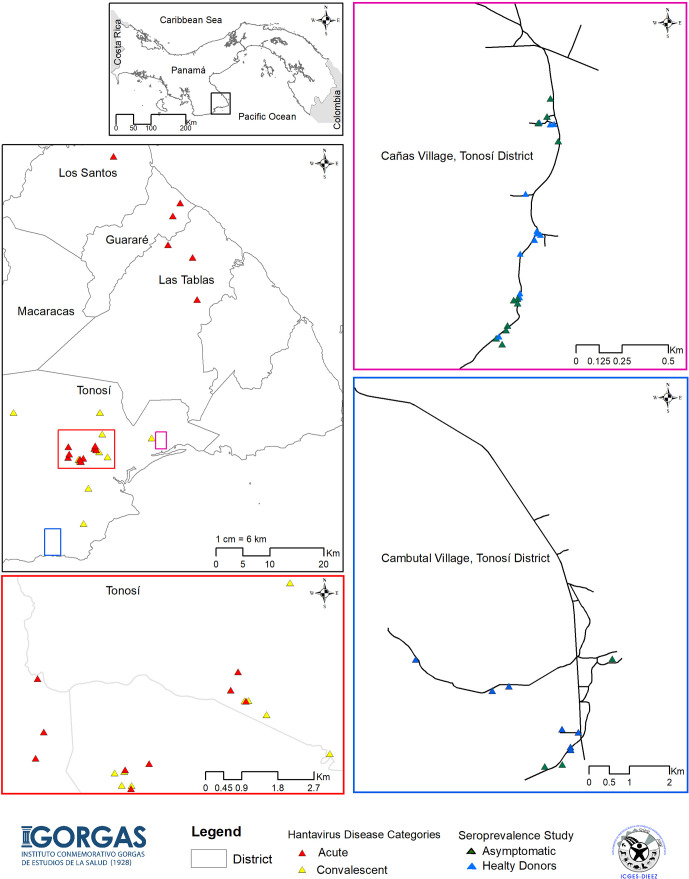
Map of the study showing HCPS endemic areas of Panama. Map of the Azuero Peninsula in Panama, HCPS endemic region, showing the location of the acute patients with HCPS (red triangle), convalescent patients (yellow triangle), asymptomatic individual (green triangle) and healthy donors (blue triangle). Large pink, blue and red squares show an enlargement of the map with more details.